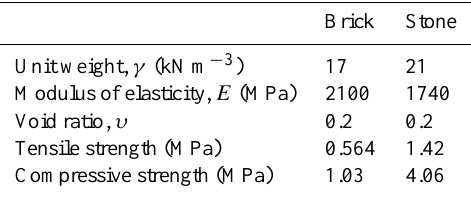
Table 2. Assumed material properties of the FE